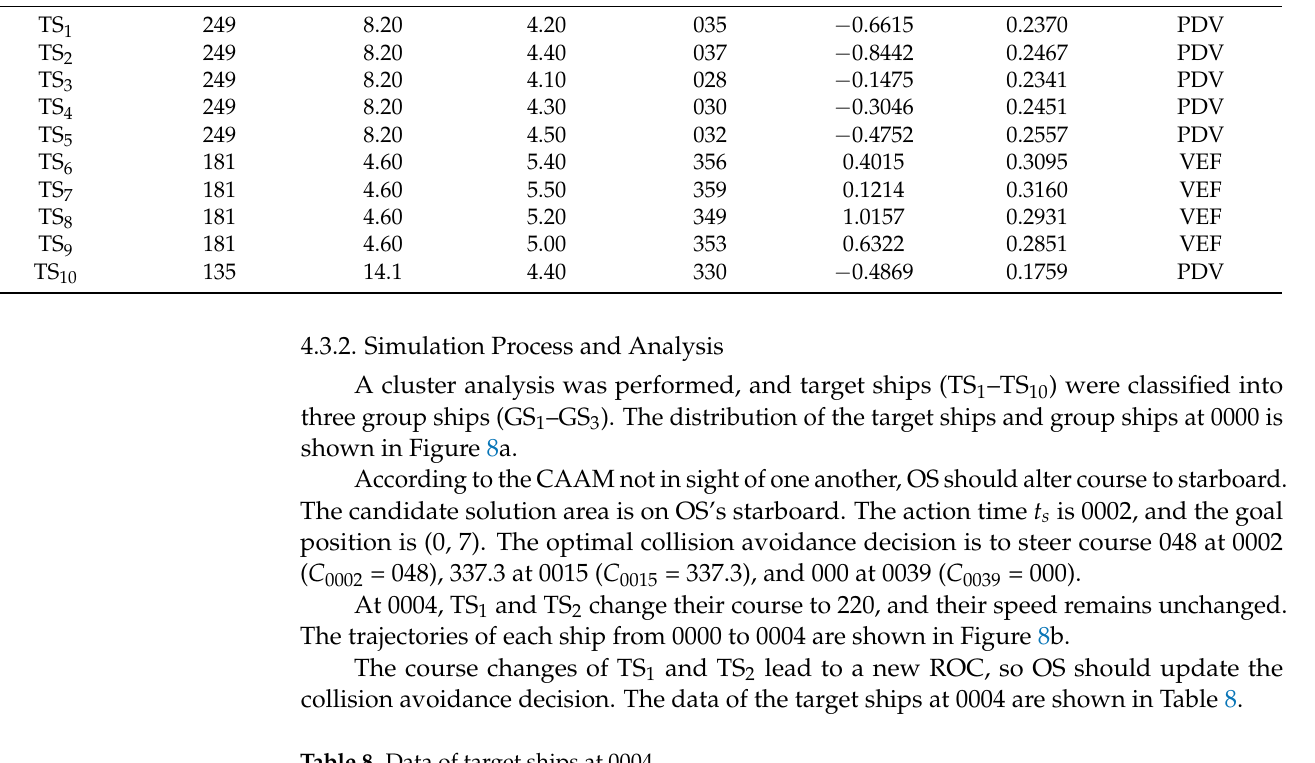
Table 8. Data of target ships at